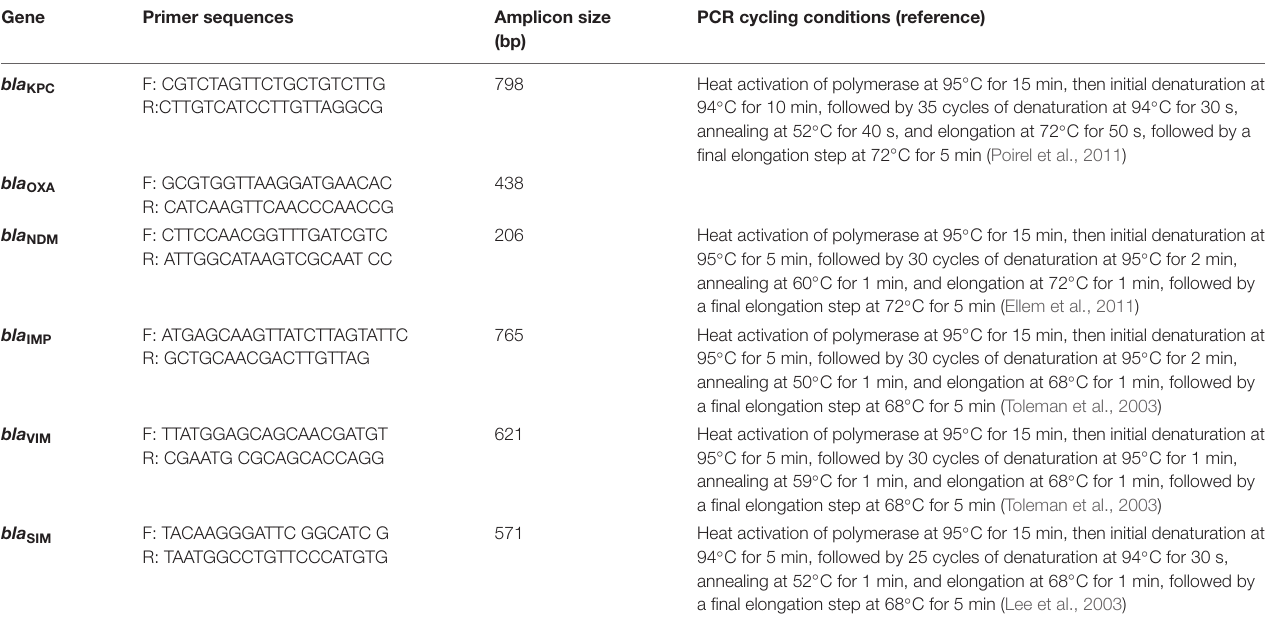
TABLE 1 | Primer sets used for PCR amplification of carbapenem-resistance genes and their expected amplicon